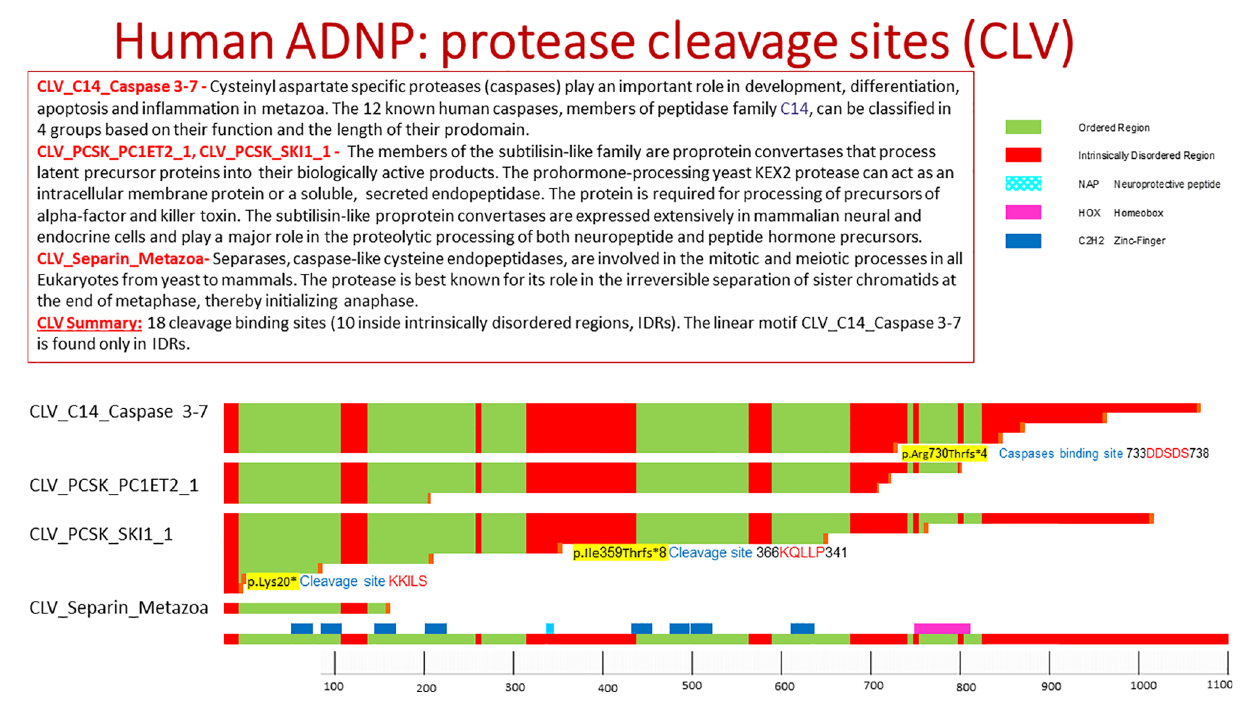
FIGURE 1 | Human ADNP protease cleavage site (CLV). The picture shows protein cleavage sites in ADNP as obtained from the ELM data base. Highlighted in the text are cleavage sites associated with somatic ADNP mutations in postmortem Alzheimer ’ s disease brains. The ELM site shows ordered and disordered structures within protein, with ordered meaning a three dimensional protein